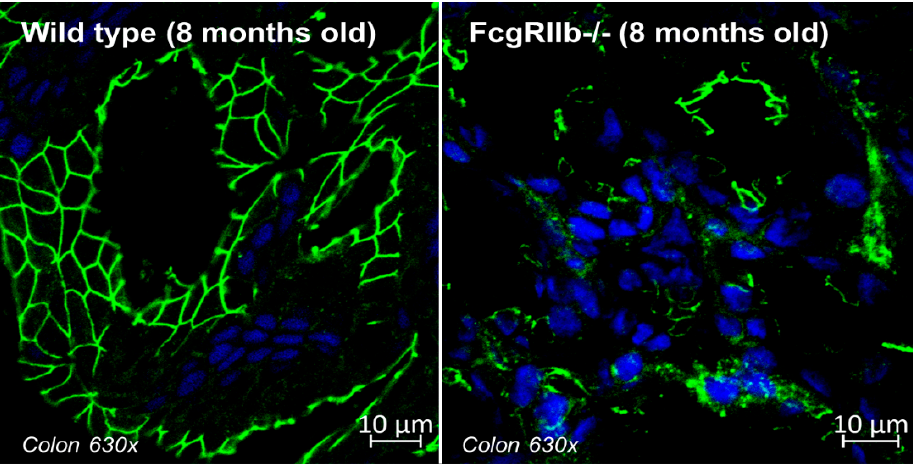
Figure 1. The representative picture of zona occludens-1 (ZO-1, green fluorescent color), a tight junction protein, in enterocyte of the colon from 8-week-old mice of wild-type control and FcgRIIb-/- lupus mice are demonstrated (original magnification 630×) [26]. The blue color is the staining of the nucleus using DAPI (4 ′ ,6-diamidino-2-phenylindole), a blue-fluorescent DNA stain (Alexa Fluor 488, Abcam, Cambridge, MA, USA). The samples were prepared in Cryogel (Leica Biosystems, Richmond, IL, USA) and photographed by a ZEISS LSM 800 (Carl Zeiss, Germany). Notably, there is a well-defined green color border in wild type versus the unclear borders of ZO-1-stained colon in FcgRIIb-/- lupus mice at 8 weeks old (full-blown lupus).